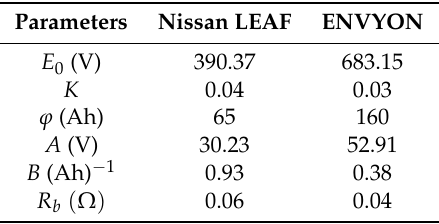
Table 2. Battery